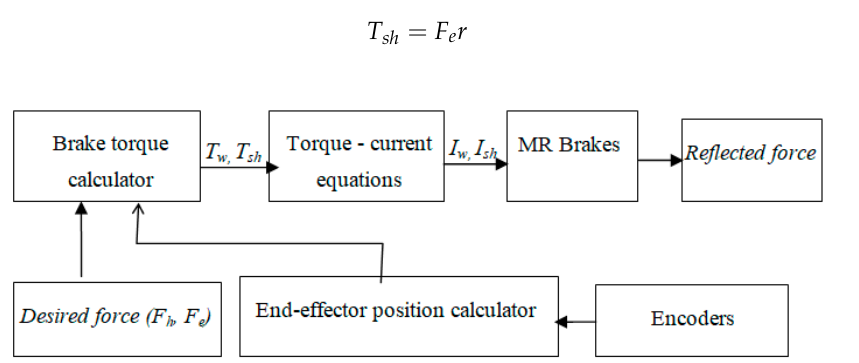
Figure 16. Block diagram of the control system for tangent force.